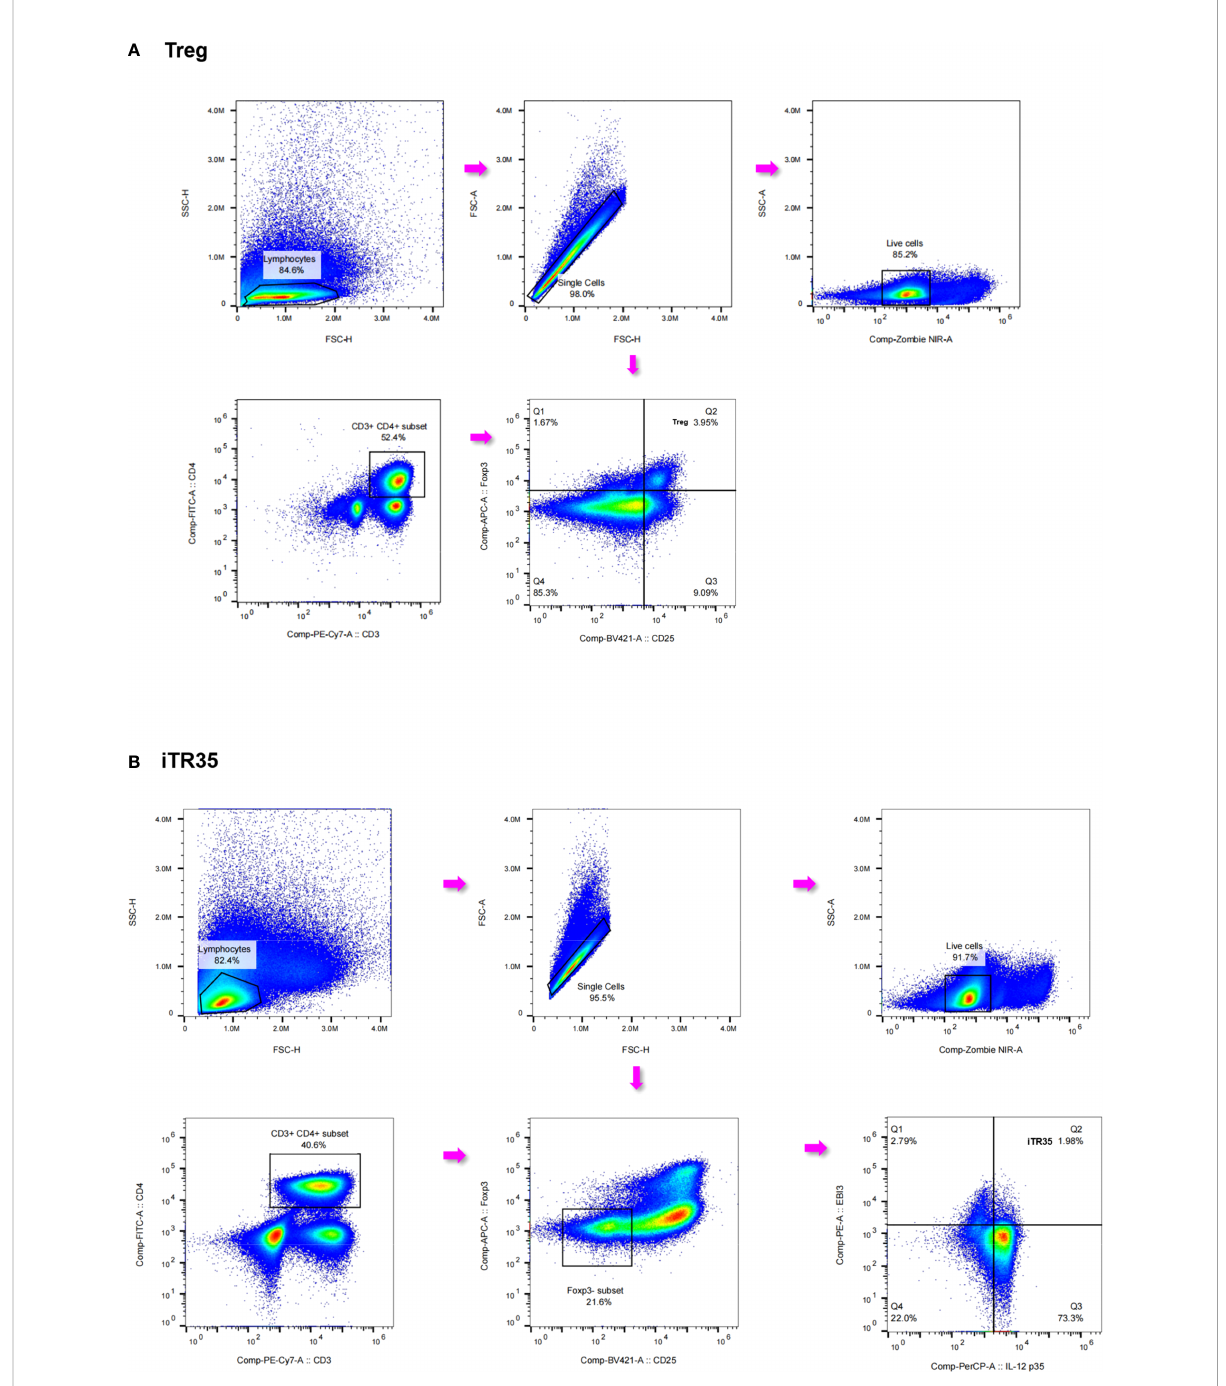
FIGURE 6 Flow gating strategy and representative diagram of iTR35 and Treg. Flow cytometric analysis of Treg and iTR35 cells frequency in the peripheral blood of IMN patients. (A) Treg (CD3 + CD4 + CD25 + Foxp3 + T cells) gating strategy and representative diagram of IMN patients. The picture sequence is: lymphocytes are identi fi ed in PBMC., adherent cells are removed, dead cells are removed, CD3+CD4+ cells and CD25+Foxp3+ cells. (B) iTR35 (CD3 + CD4 + CD25 - Foxp3 - EBI3 + IL-12p35 + T cells) gating strategy and representative diagram of IMN patients. The picture sequence is: lymphocytes are identi fi ed in PBMC., adherent cells are removed, dead cells are removed, CD3+CD4+ cells, CD25-Foxp3-cells and EBI3+IL-12p35+cells. SSC, side scatter; FSC, forward scatter; NIR, near-infrared; FITC, fl uorescein isothiocyanate; APC, allophycocyanin; PE, phycoerythrin; EBI3, Epstein-Barr virus-induced gene 3; IL, interleukin; Foxp3,forkhead box p3; Treg, regulatory T; iTR35, IL-35-induced regulatory T; PBMC, peripheral blood mononuclear